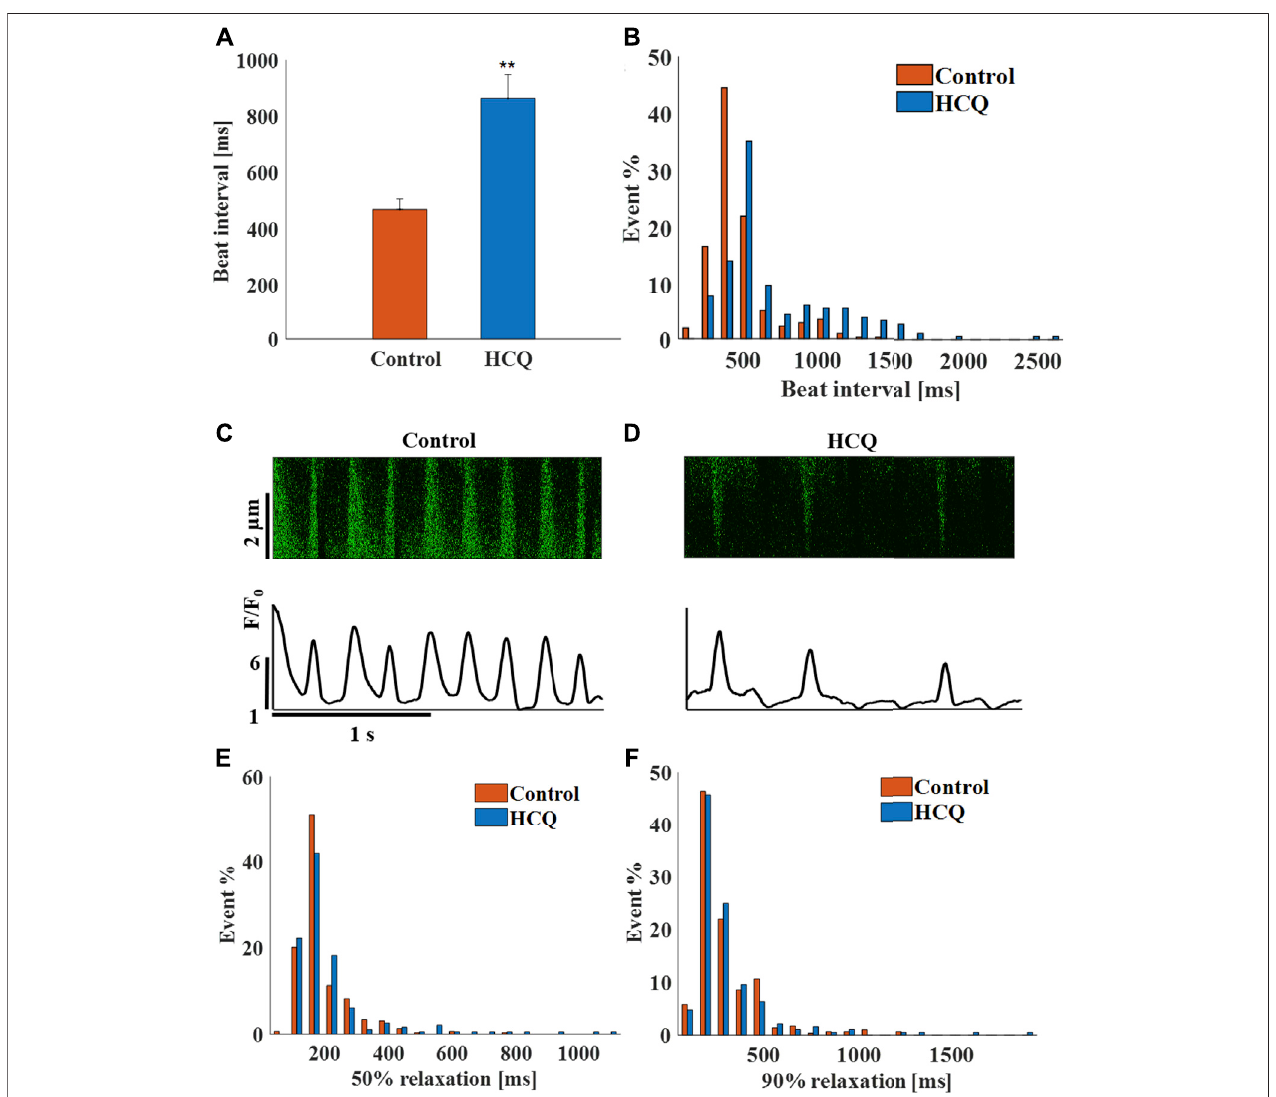
FIGURE 4 | The effect of hydroxychloroquine (HCQ) on micesinoatrial (SAN) cells residing in the SAN. (A) Mean beating interval and (B) beat interval distribution in control and in 10 μ M HCQ-treated SAN ( n = 23). Representative example of Ca 2+ transients in (C) control and in (D) 10 μ M HCQ-treated SANs. The distribution of